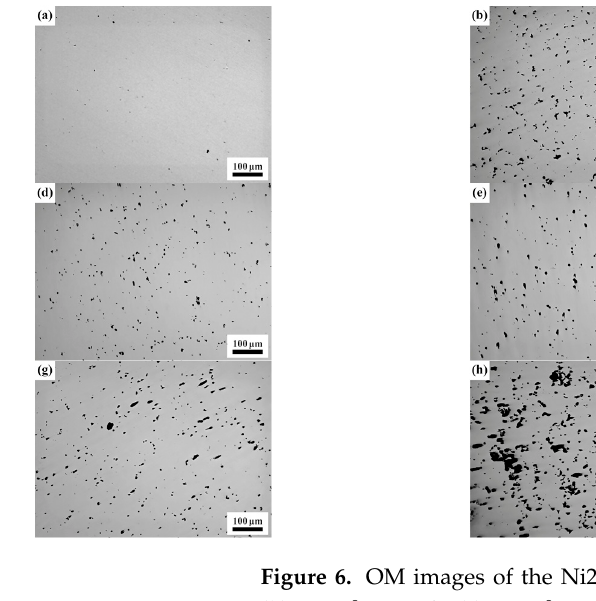
Figure 5. OM images of the Ni1# superalloy after solution heat treatment, ( a ) 1150 °C × 0.5 h, ( b ) 1150 °C × 2 h, ( c ) 1150 °C × 4 h, ( d ) 1150 °C × 8 h, ( e ) 1175 °C × 0.5 h, ( f ) 1175 °C × 2 h, ( g ) 1175 °C × 4